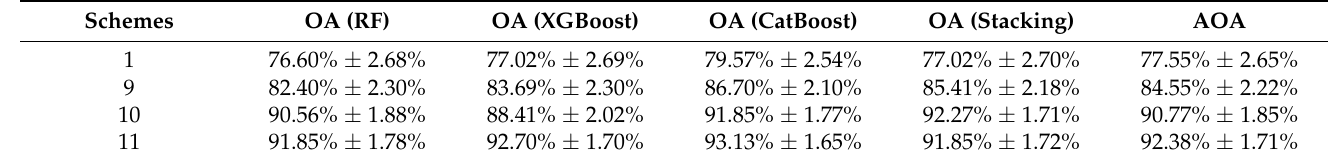
Table 8. Overall accuracy and standard errors of each classification model by integrating hyperspec- tral and quad-polarization SAR images. OA, overall accuracy; AOA, average overall